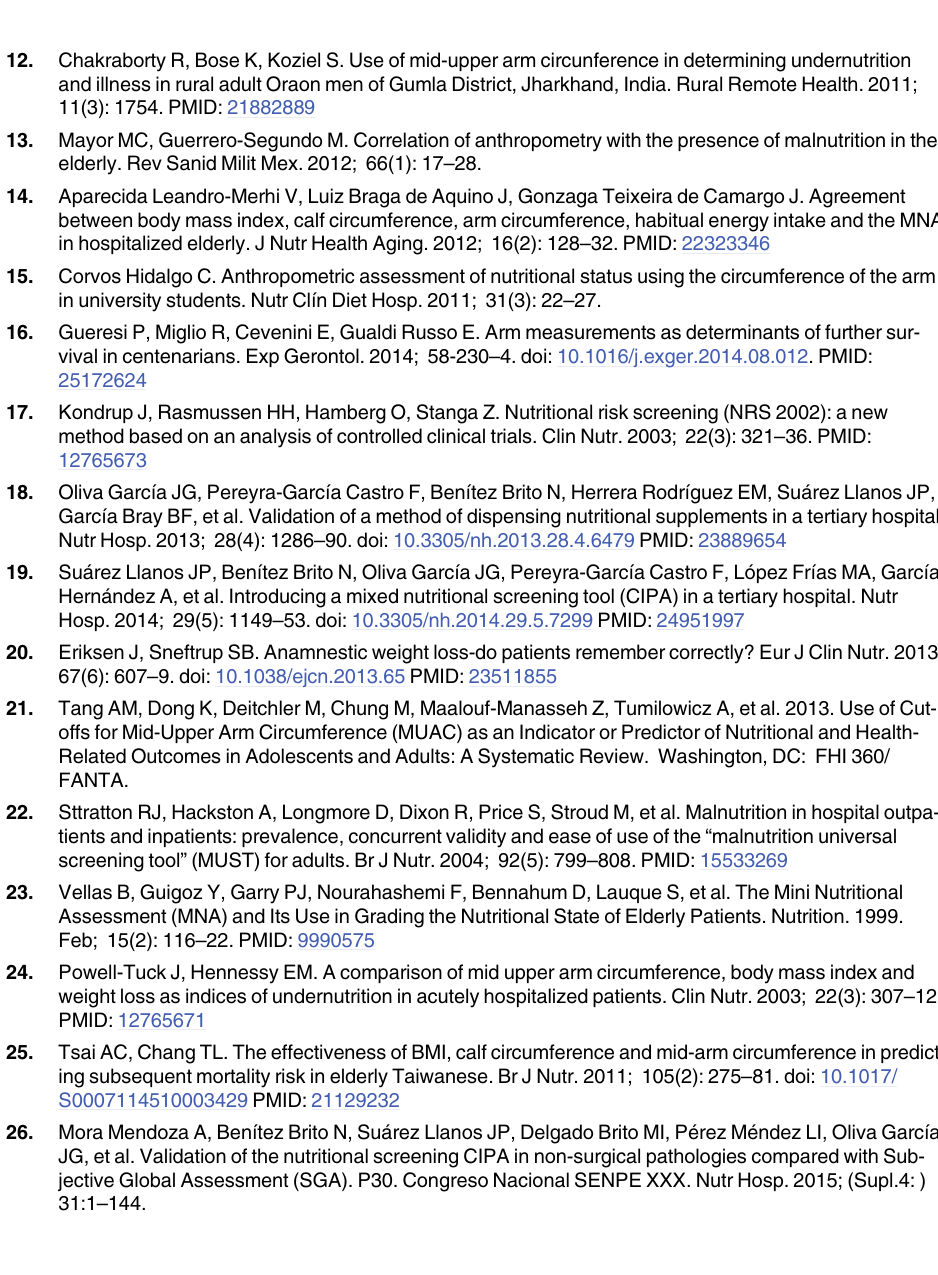
PLOS ONE | DOI:10.1371/journal.pone.0160480 August 5,